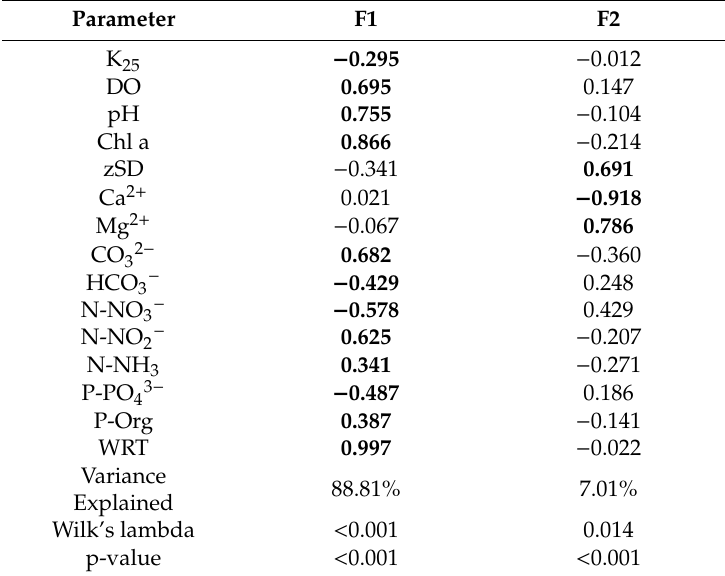
Table 4. Correlations with discriminating functions.